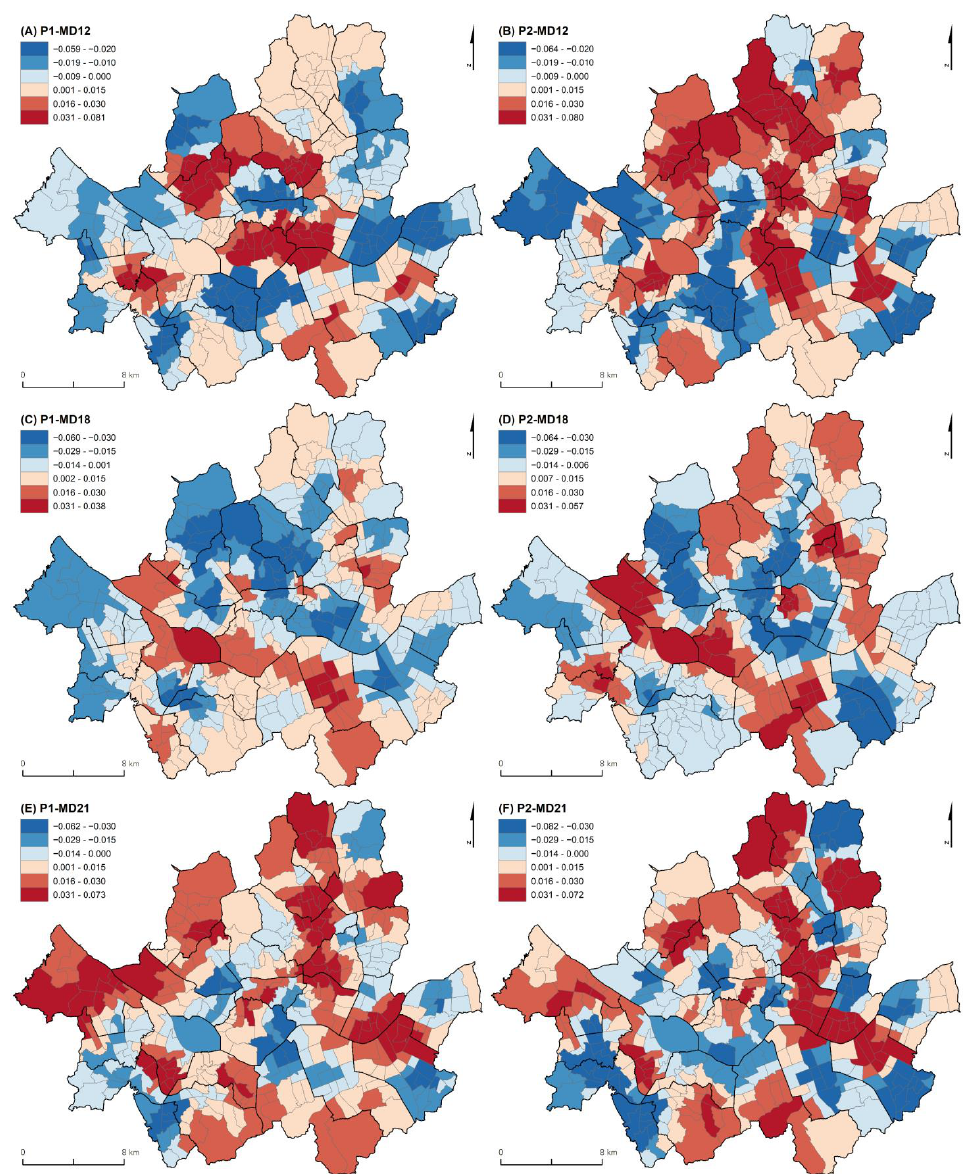
Figure 4. Spatio-temporally varying coefficients of location mobility on weekdays; ( A ) MD12 in P1, ( B ) MD12 in P2, ( C ) MD18 in P1, ( D ) MD18 in P2, ( E ) MD21 in P1, and ( F ) MD21 in P2.